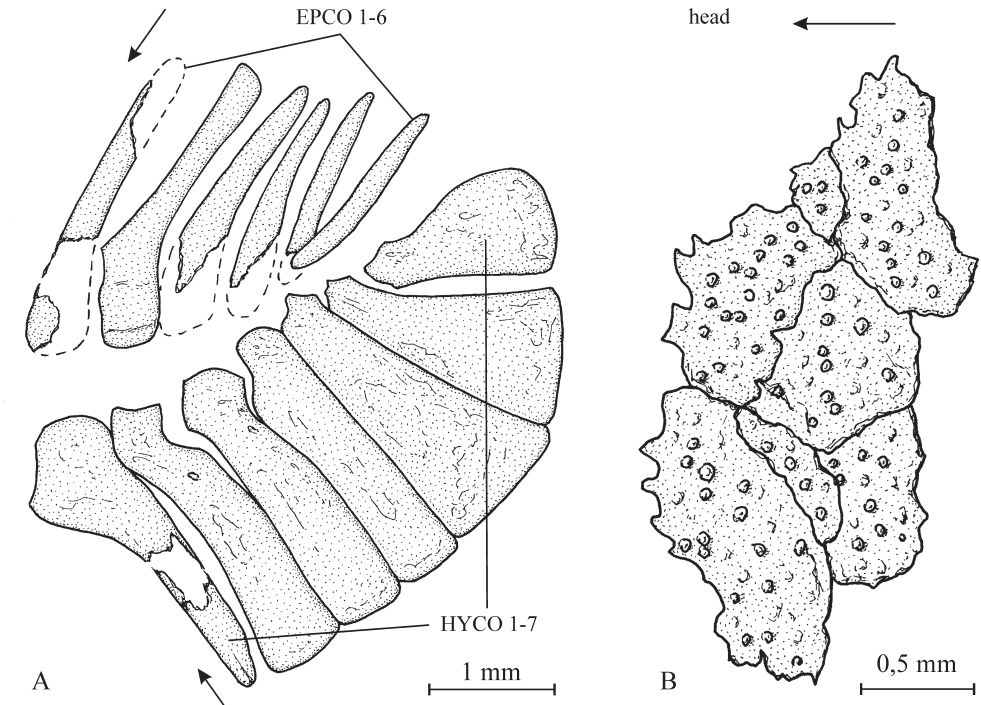
Fig. 21. Rostropycnodus gayeti gen. et sp. nov. A . Caudal skeleton of holotype CLC S-608a. The arrows point on the more external procurrent rays of the caudal fin. B . Body scales of paratype CLC